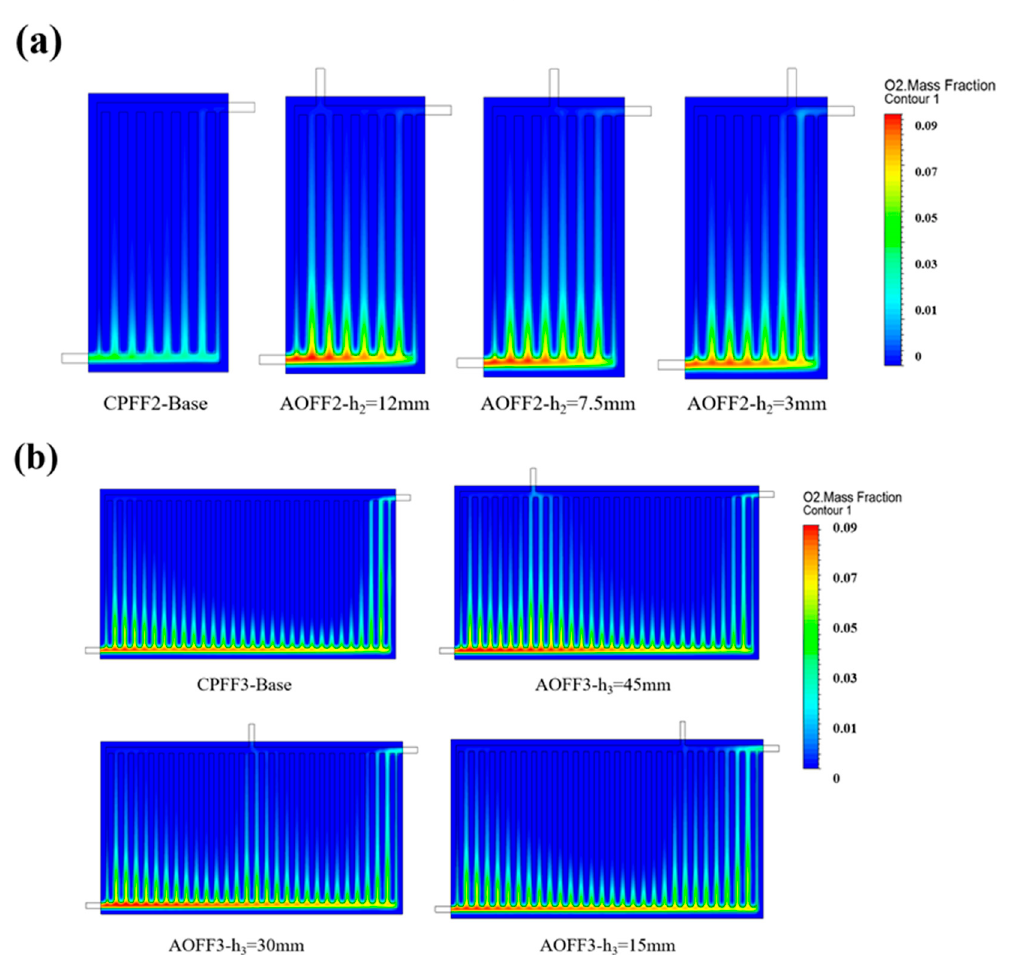
Figure 11. Oxygen mass fraction on the cathode CL–GDL interface at Vcell = 0.5 V. ( a )The proportion is 4.5 cm 2 ( b ) The proportion is 18 cm 2 .